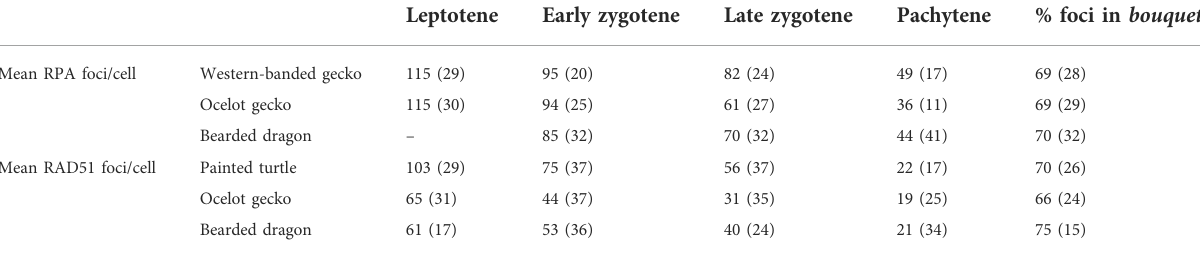
TABLE 1 Dynamics of DSB formation during prophase I in the four reptiles included in the study. Values indicate the average number of RPA or RAD51 foci per cell immunodetected in leptotene, early zygotene, late zygotene, and pachytene, as well as the fraction of the total foci per cell detected in the bouquet . Values in parenthesis indicate the number of cells analyzed in each